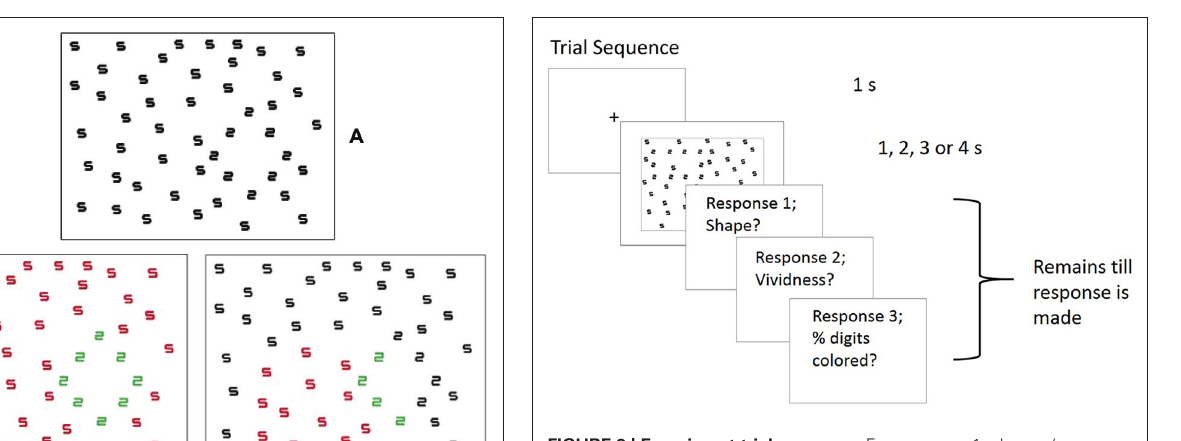
FIGURE 2 | Experiment trial sequence. For response 1, shapes (square, rectangle, diamond and triangle) were presented with response keys underneath (keys 1–4). Response 2, was measured using a six point scale (1 = no color, 6 = very vivid color) followed by response 3, the percentage of digits within the array which were colored which was typed by the